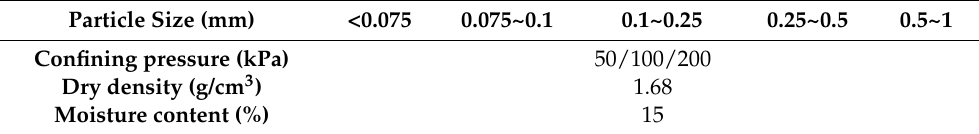
Table 3. Parameters before a single particle size saturation test.